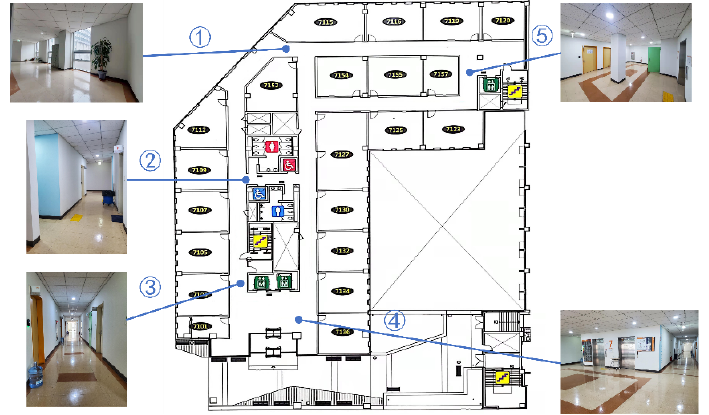
Figure 11. Real scene for Owlbot SLAM testing. Owlbot leaves from ① , goes through ② , ③ , ④ , and ⑤ , and finally returns to ① .